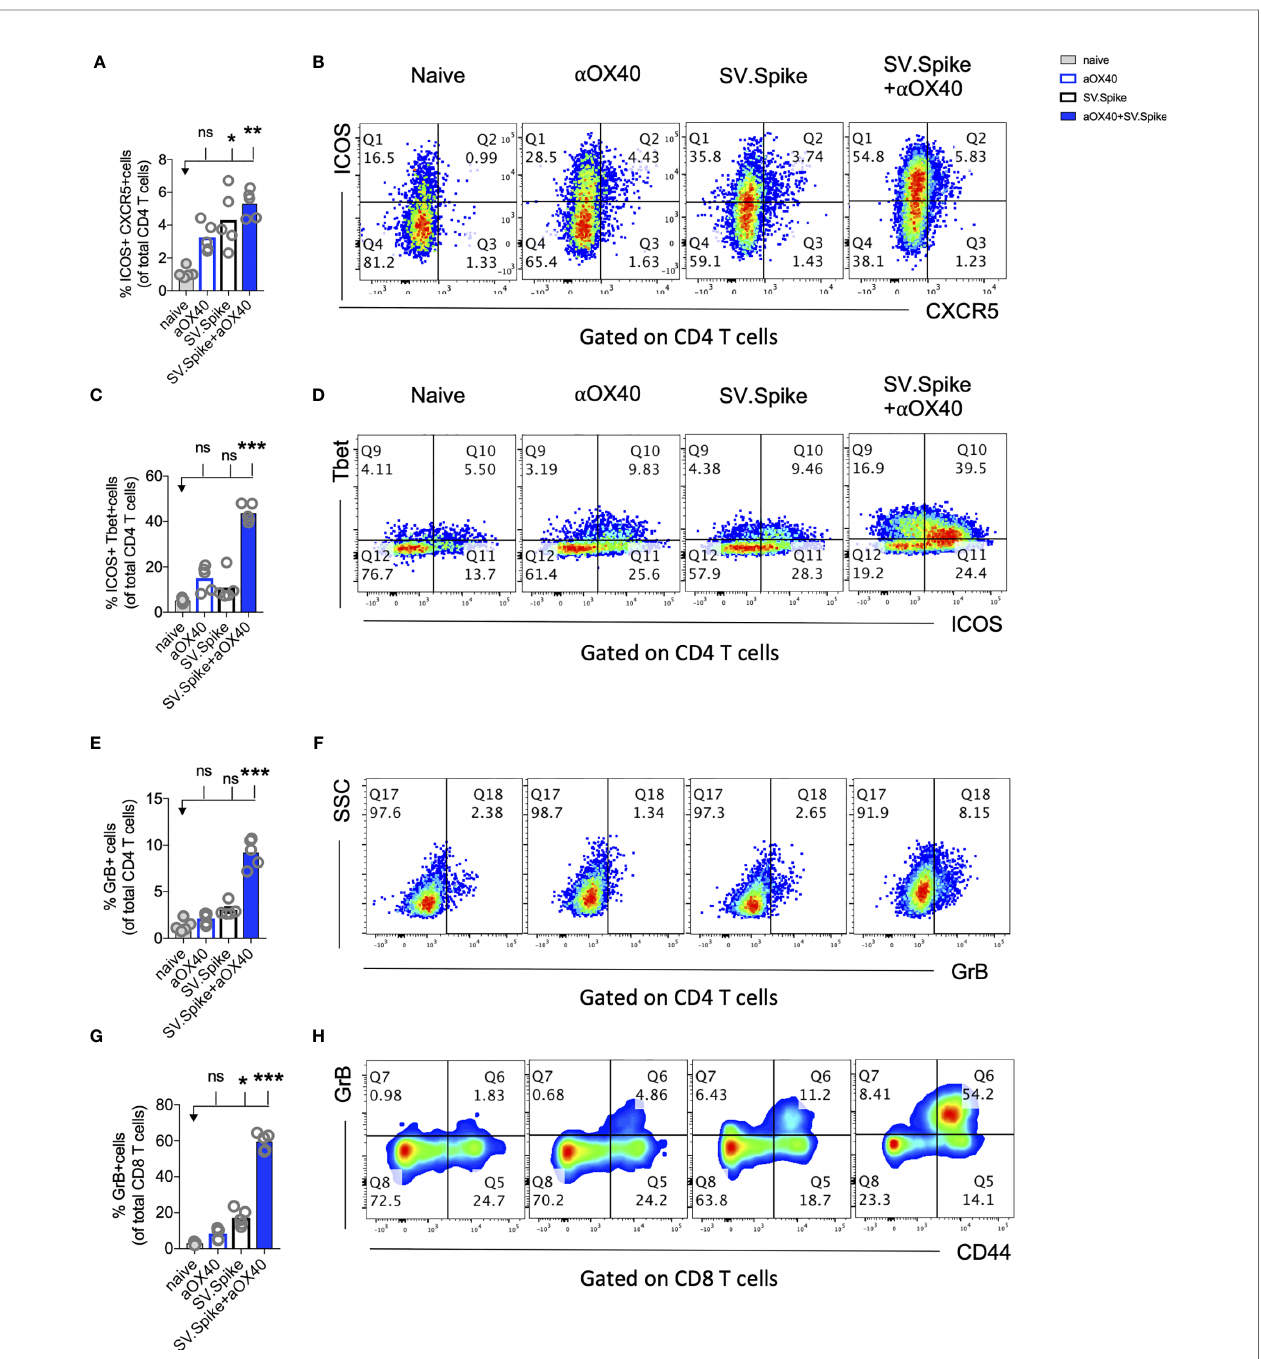
FIGURE 9 | Combination of SV.Spike and a OX40 promotes robust tissue speci fi c Tfh-like T cell immune response in lungs. Presence of activated T cells in lungs after 21 days after prime vaccine doses indicate tissue speci fi c immune protection. C57BL/6J mice were immunized by a Prime/Boost strategy with SV.Spike and/or a OX40 and lungs were excised and a single cell-suspension was stained for fl ow cytometry analysis. Naive mice were used as control. (A) CD4+ Tfh type T cells presence in the lung indicated by ICOS+CXCR5+ double-positive CD4+ T cells. (B) Representative plots. (C) Expression of ICOS+Tbet+ double positive CD4+ T cells indicating Th-1 type effector cells polarization and recruitment to the lungs. (D) Representative plots. (E – H) Cytotoxic T cells in lungs indicated by (E) Granzyme B positive CD4+ T cells and representative plots (F) and CD8+ effector T cells indicated by GrB+ and representative plots (G, H) . Bars or symbols represent means ± SEM. Each symbol represents one individual mouse. Statistical signi fi cance was determined with the Kruskal-Wallis test followed by Dunns ’ test. n.s. > 0.05, *p<0.05, **p<0.005, ***p ≤